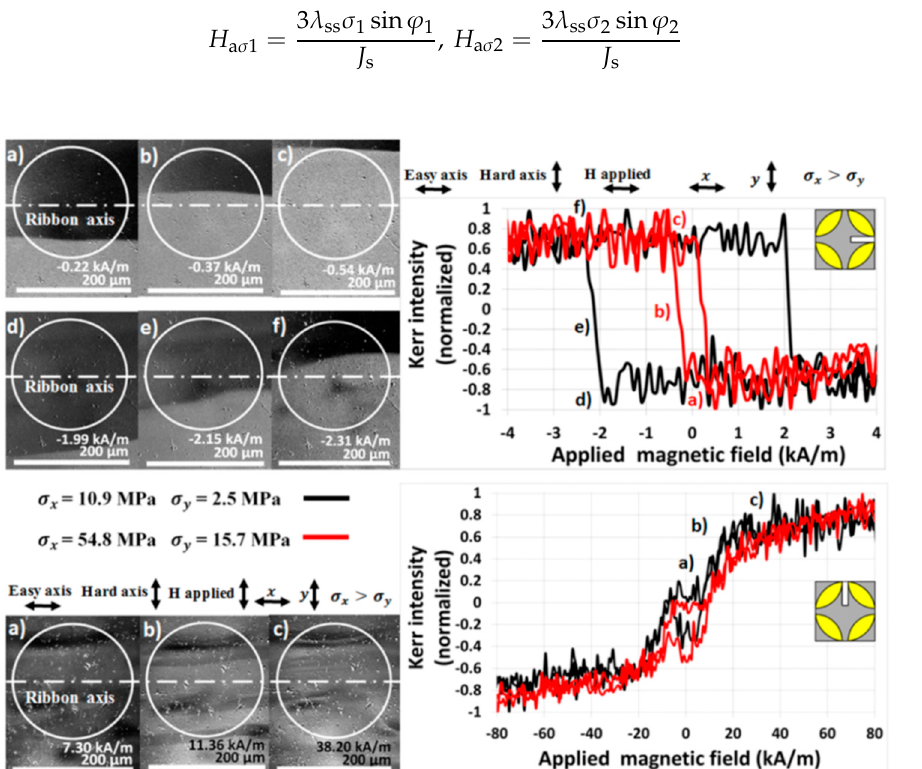
Figure 9. Surface magnetic domains (left) and magnetization curves (right) of the sample (5 × 8) mm 2 exposed to tensile stress and measured using the longitudinal MOKE configuration related to magnetization M x (upper panel) and M y (lower panel).